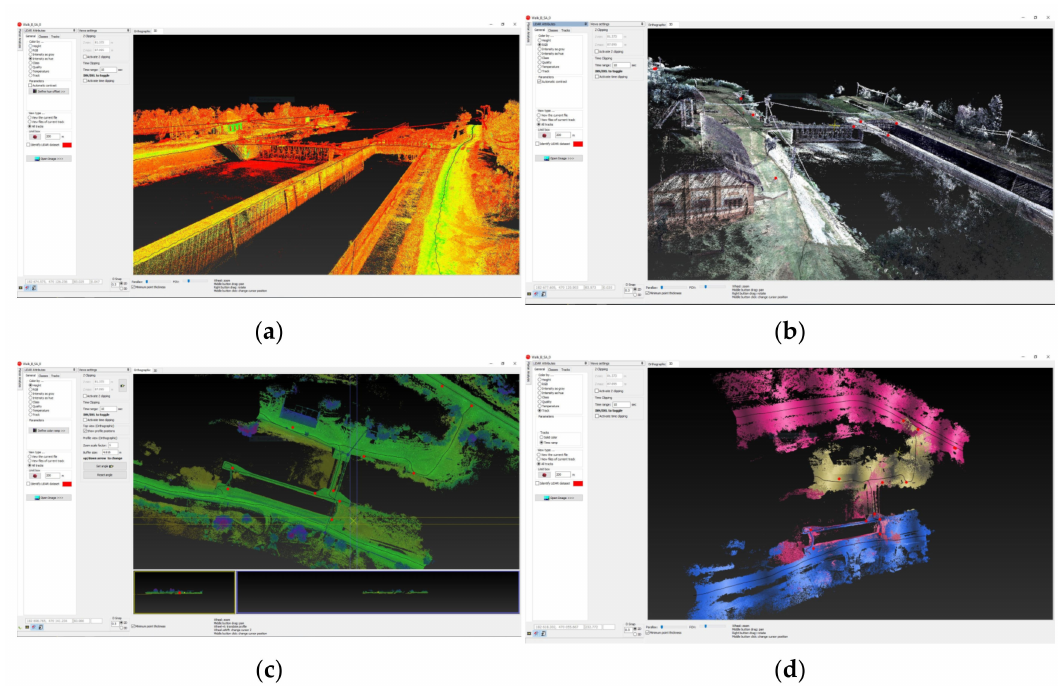
Figure 33. S â nmartinu Maghiar Lock, Timis , Romania, scan performed on 23 July 2019: ( a ) The nuance , intensity of the LiDAR data, orthographic visualization; ( b ) View point clouds (RGB); ( c ) LiDAR data coloured by altitude; ( d ) Coloring of point clouds after walks.